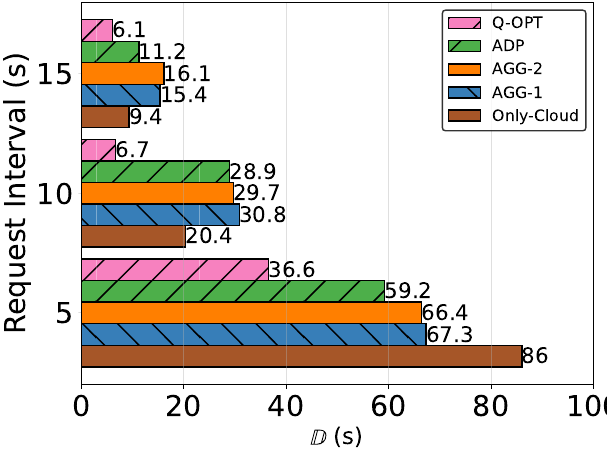
Figure 7. Impact of task inter-arrival time on the objective function D .